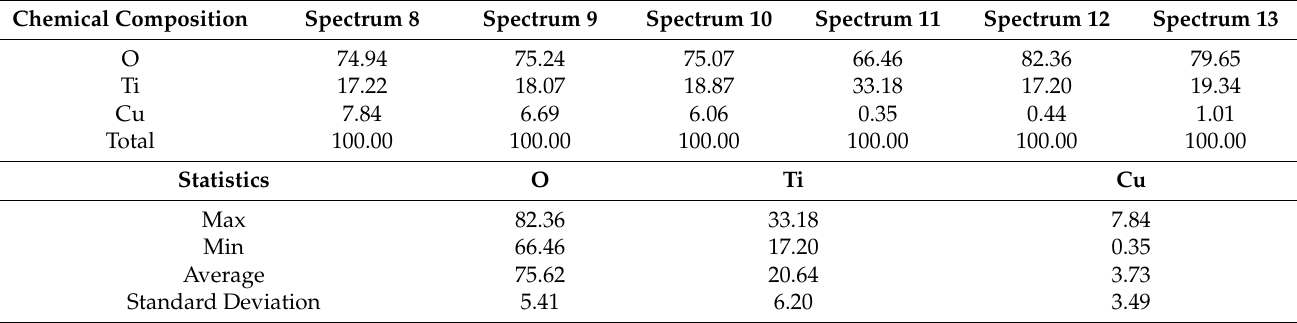
Figure 8. Determination of powder composition by EDX. Table 2. Composition of the